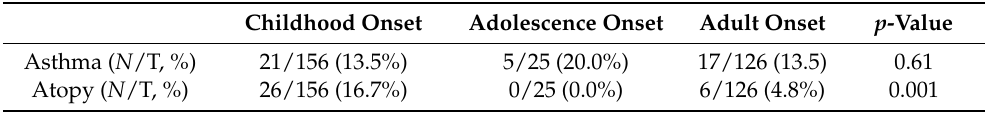
Table 5. Prevalence of atopy and asthma in patients with NREM parasomnia split by age of onset ( p at 0.05/3 =